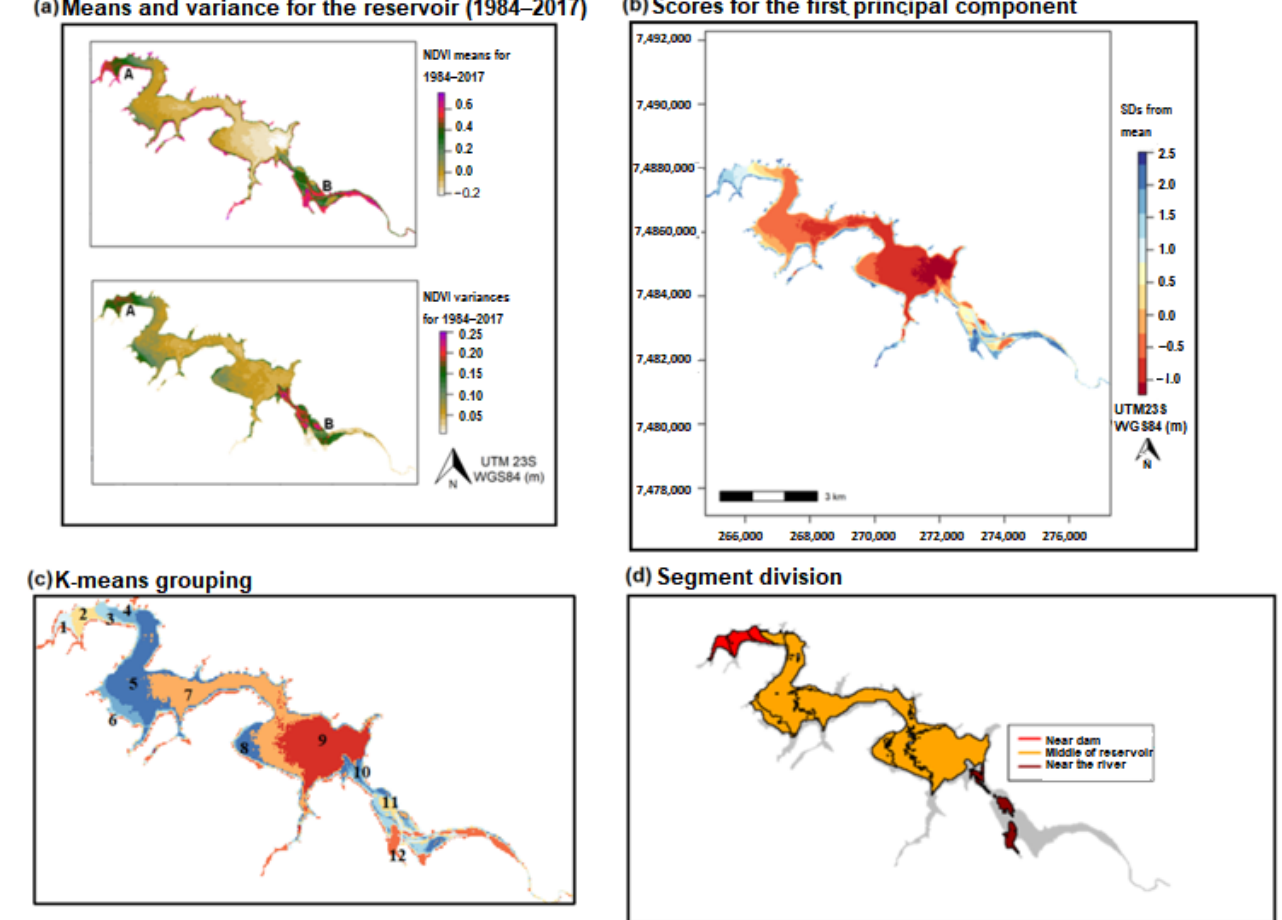
Figure 3. Definition of homogeneous areas in the reservoir based on the NDVI temporal variability: Spatiotemporal distribution of the mean and the variance of the NDVI in the reservoir in the period 1984 to 2017 ( a ); spatial distribution of the PC1 scores ( b ); the twelve areas obtained by k-means clustering of PC1 scores ( c ); and the same areas aggregated into three compartments: near dam, reservoir body, and near the river ( d ).